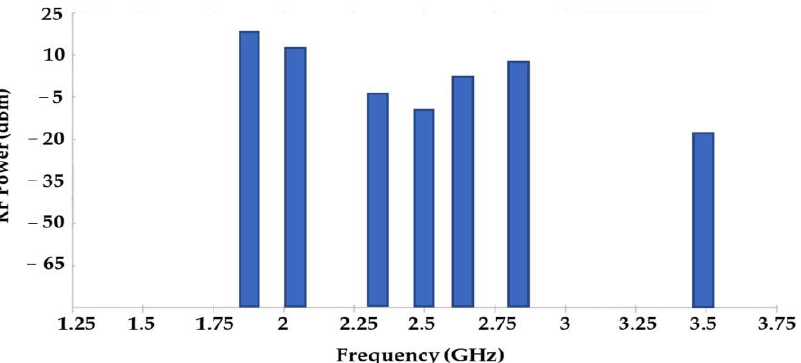
Figure 3. Measured ambient RF power at 22 m from mobile communication base station.